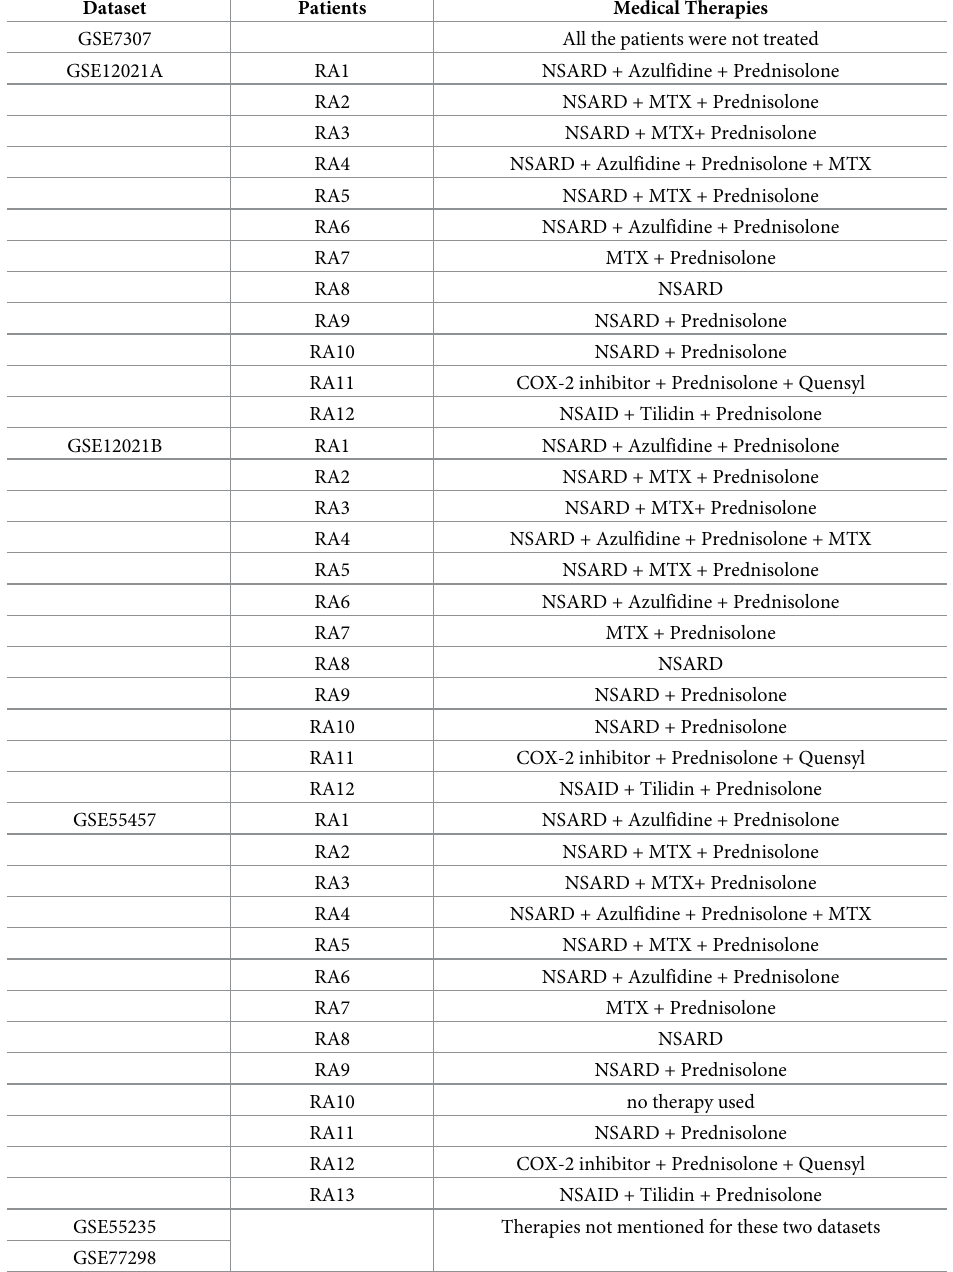
Table 3. Medical therapies initiated on RA patients that participated in the microarray studies.